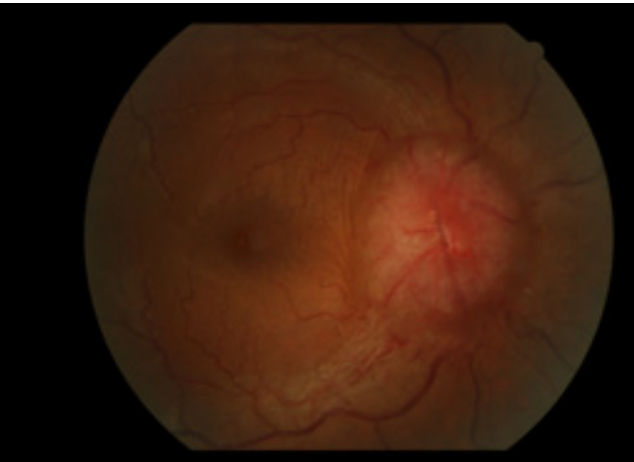
Figure 1 . Patient GF: Right swollen disc and smaller inferior